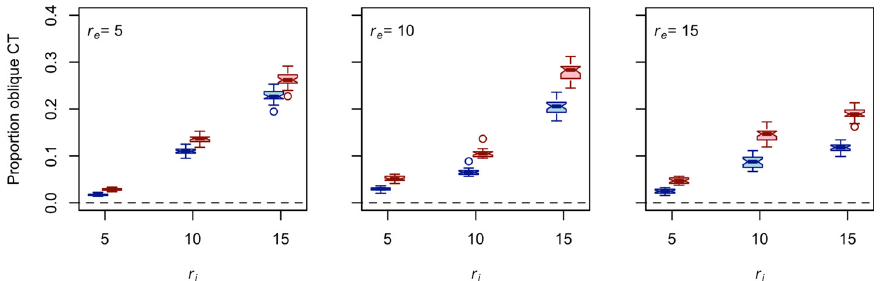
Fig 2. Increasing interaction radius r i increases the proportion of times that trait A (blue) and trait B (red) are passed via oblique cultural transmission. Each boxplot represents data collected from 30 unique simulation runs. The length of the effective foraging radius increases from the left panel to the right panel. The dashed line provides the value associated with the boundary condition of extreme uniparental vertical cultural transmission. The other boundary condition, represented by a Wright-Fisher population, is associated with a value of 0.96. Note that d = 0.75 and that these results are exactly the same for all values of μ